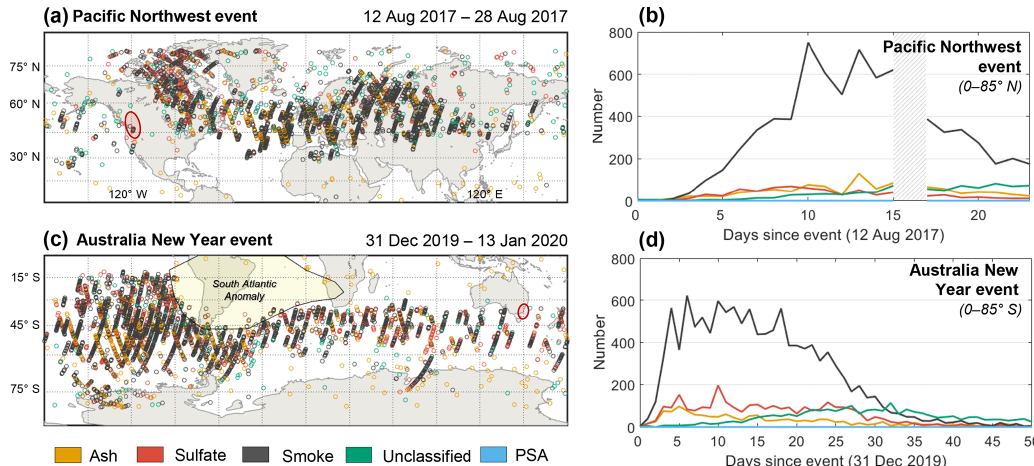
Figure 20. Same as Fig. 15 but for smoke-dominated events. PyroCb locations are denoted by red ovals. Approximate area affected by SAA is denoted by the yellow polygon.